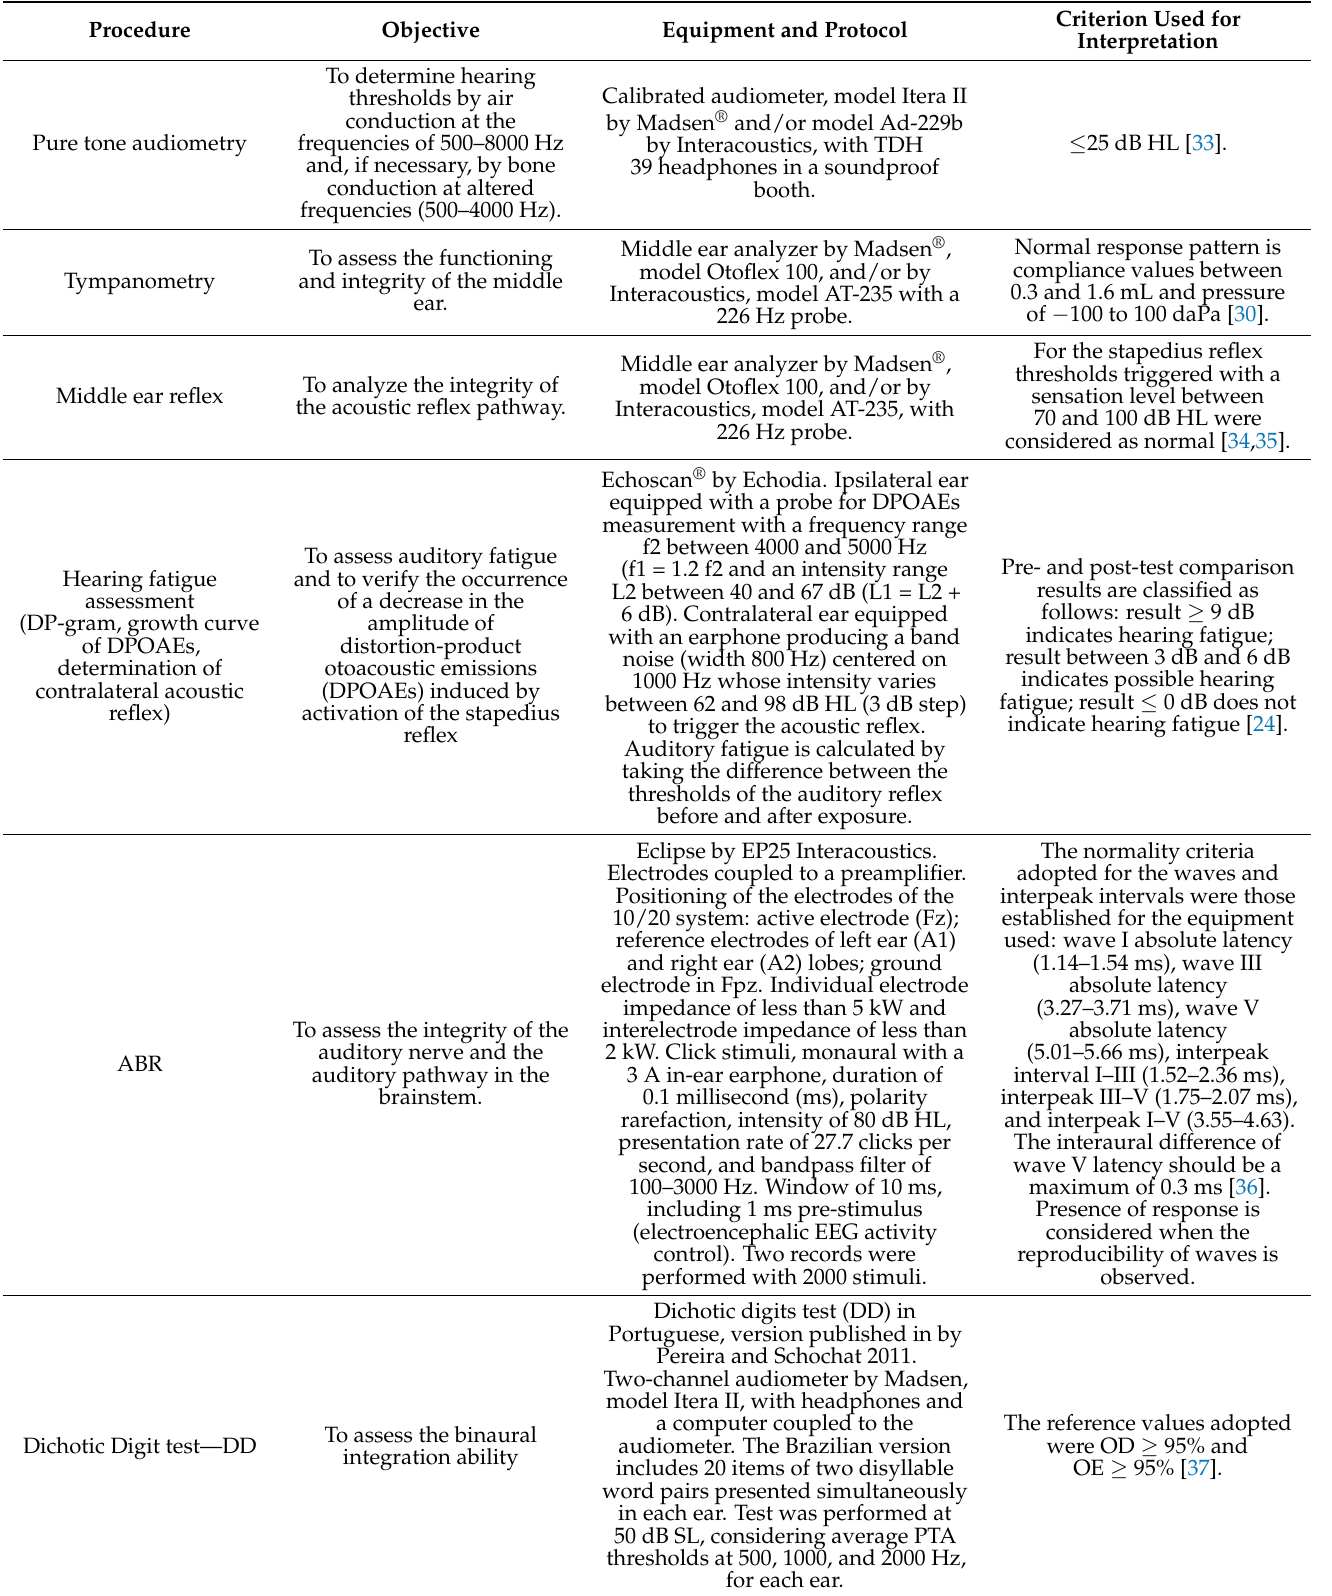
Table 1. Audiological test battery used in the